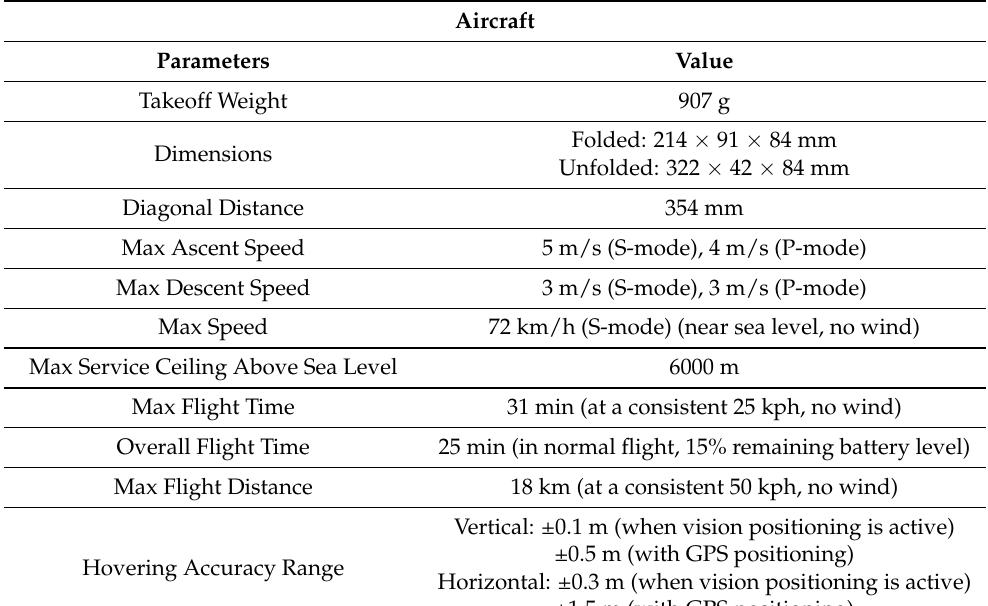
Table A9. The configuration of ‘DJI Mavic 2 Pro’.